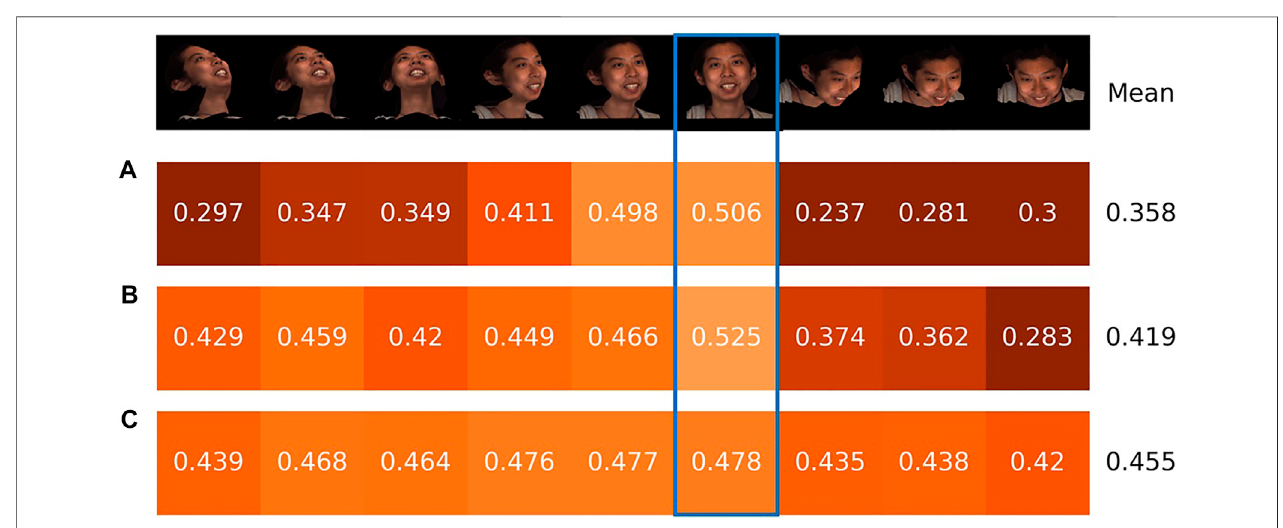
The best results are shown in bold.